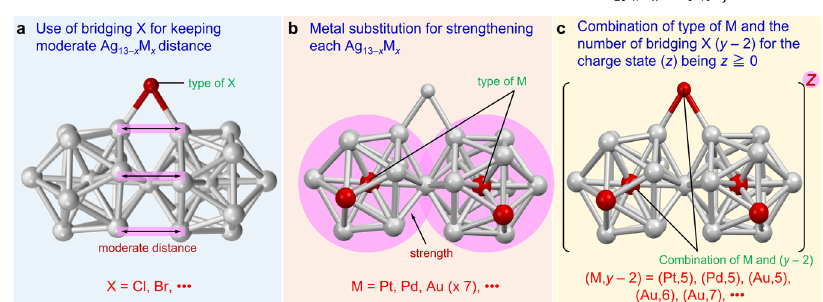
Fig. 8 Indispensable requirements for stabilising and thereby isolating [Ag 25 − x M x (PR 3 ) 10 X y ] z . a Use of a bridging X with a relevant ion radius (grey = Ag or M; red = bridging X). b Metal substitution for strengthening each Ag 13 − x M x (grey = Ag; red = M). c Combination of types of M and the number of X (y − 2) for a charge state (z) with high resistance to oxidation (grey = Ag; red = M or bridging X). COMMUNICATIONS CHEMISTRY| (2023) 6:57